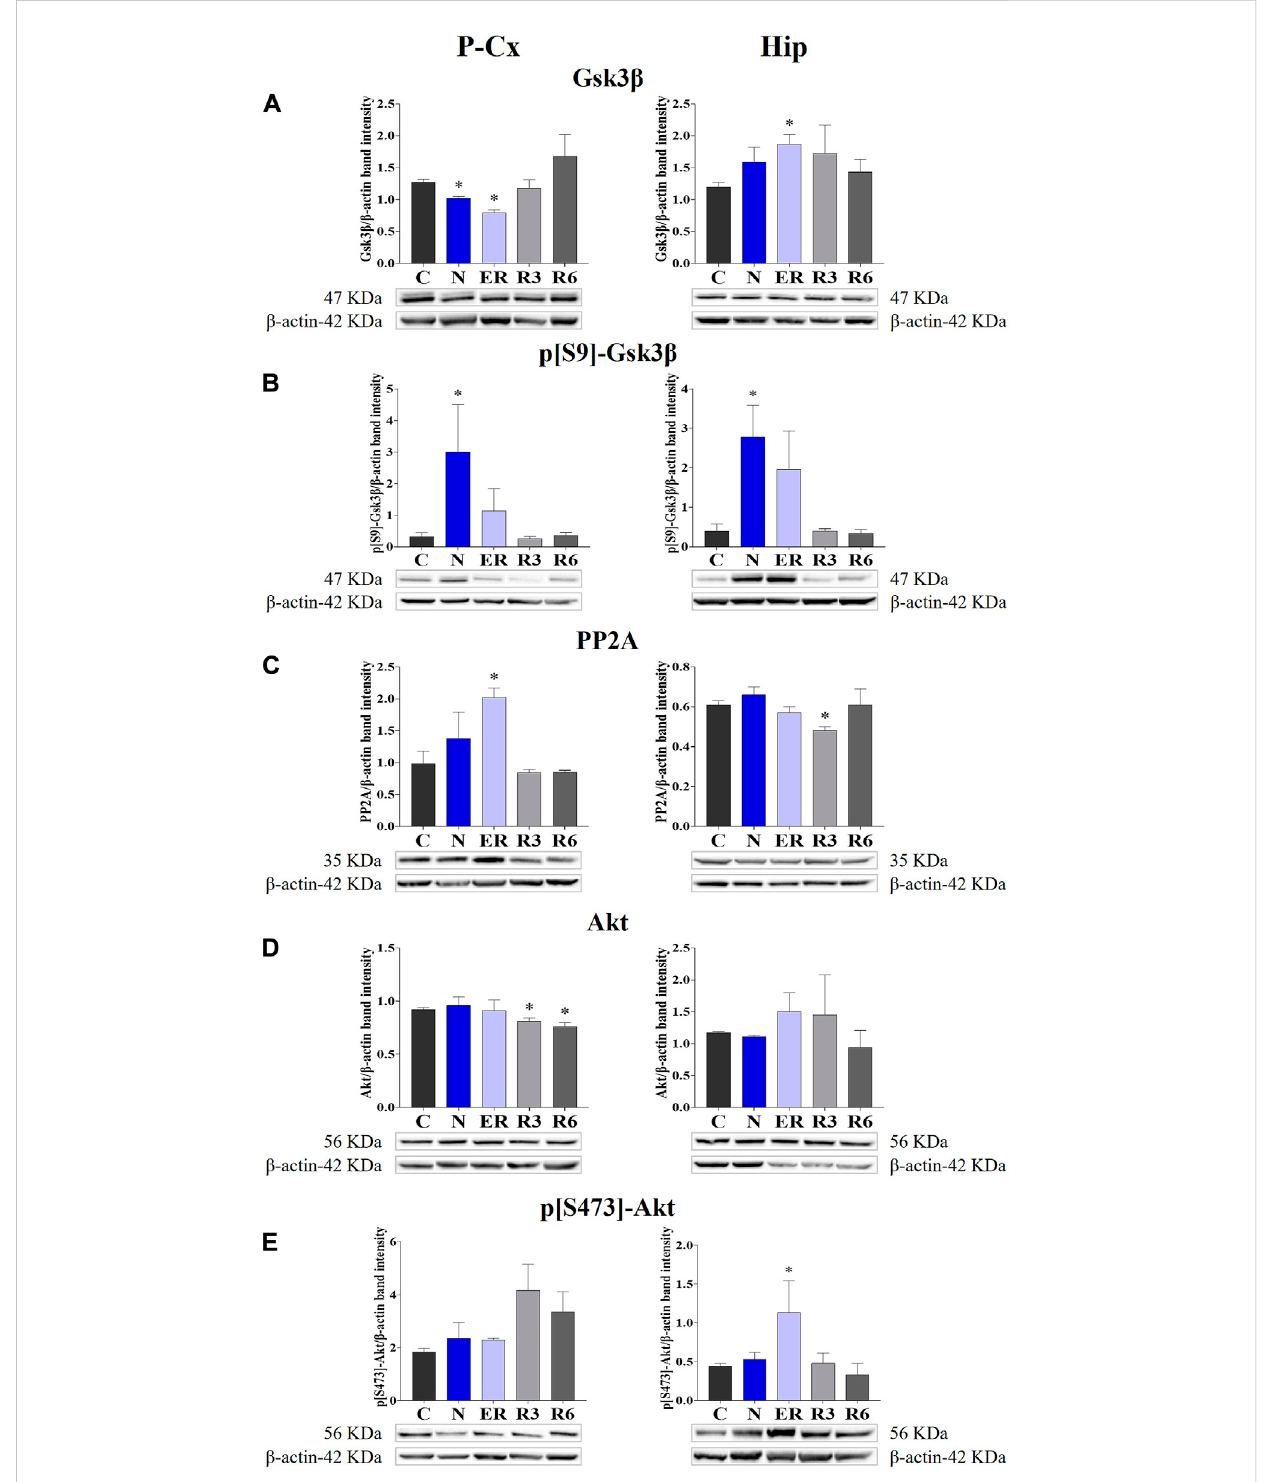
FIGURE 4 Western blot detection of the main enzymes involved in phosphorylation and dephosphorylation of Tau, determined in brain extracts of the parietal cortex (P-Cx) and hippocampus (Hip). Below each histogram, WB representative samples are shown for each experimental condition. (A) glycogen- synthasekinase-3 β (GSK3 β ),themainkinasetargetingTau; (B) p[S9]-GSK3 β (inactiveformofGSK3 β ,phosphorylatedatSer9); (C) proteinphosphatase-2A (PP2A), the main phosphatase targeting Tau; (D) different isoforms of Akt (protein kinase-B; Akt 1/2/3), kinases targeting GSK3 β at Ser9 and antiapoptotic factors; (E) p[S473] Akt, the active form of Akt 1/2/3, phosphorylated at Ser473. Data are normalized by β -actin and expressed as means ± S.E.M., n = 3. *: p < 0.05 vs. C. Experimental groups (see Figure 1): C, control; N, samples taken at nadir of hypothermia, during ST; ER, early recovery, samples taken when Tb reached 35.5 ° C following ST; R3, samples taken 3 h after ER; R6, samples taken 6 h after